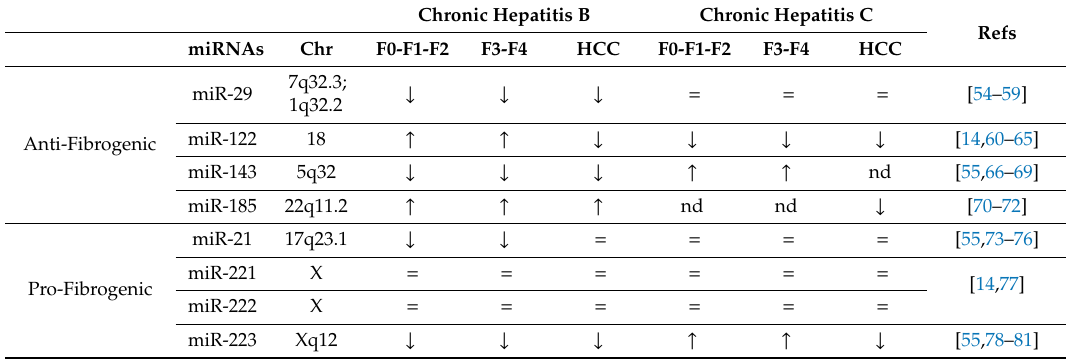
Table 1. Anti and Pro-Fibrogenic miRNAs synthesis. Expression increase ( ↑ ) decrease ( ↓ ), it is equal ( = ) or not determined